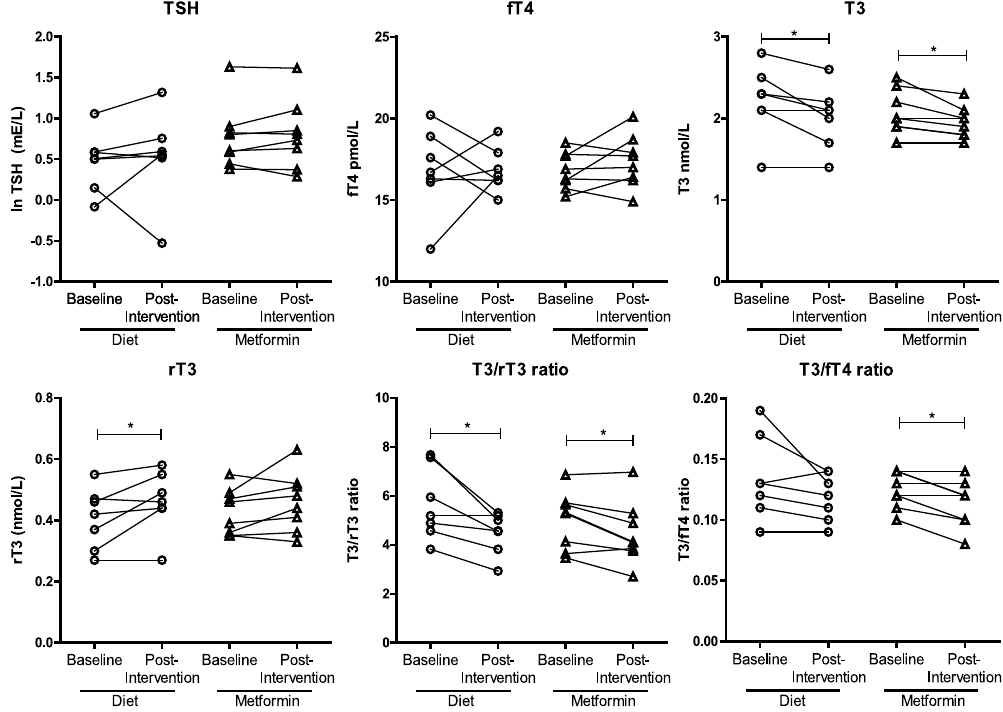
Figure 1. Effects of hypocaloric dieting and metformin on serum TSH, fT4, T3, rT3, the T3/rT3 ratio and T3/fT4 ratio in healthy volunteers before and after intervention. Serum TSH levels were log transformed and differences before and after intervention were determined with paired student’s T tests. * P < 0.05: significant effect of interventions within groups when compared with